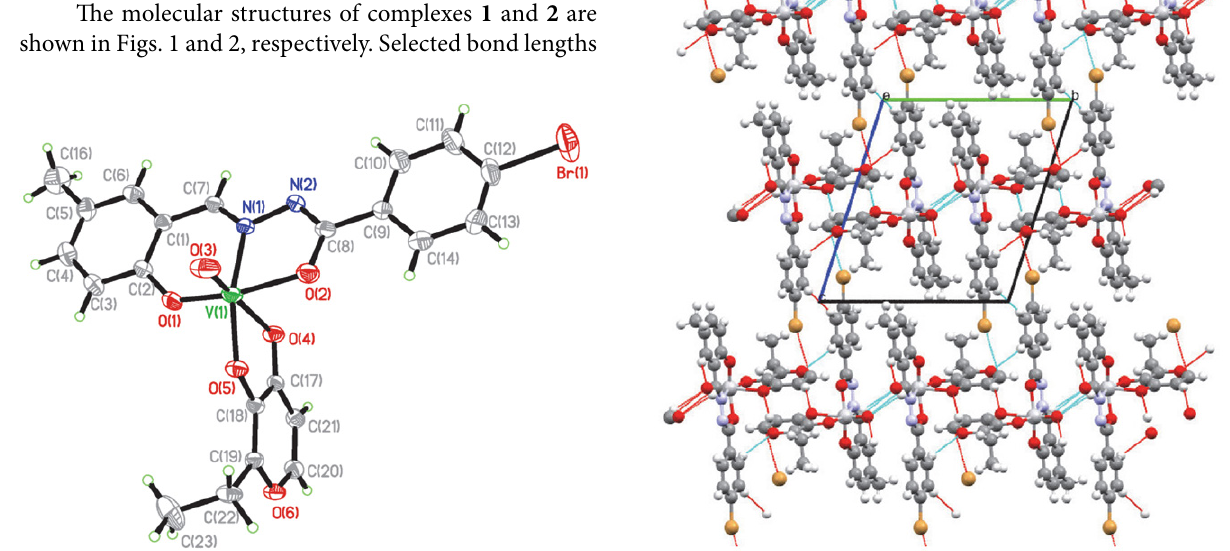
Fig. 3. Hydrogen bonds linked structures of complex 1 , viewed along the a axis. Hydrogen bonds are shown as dashed